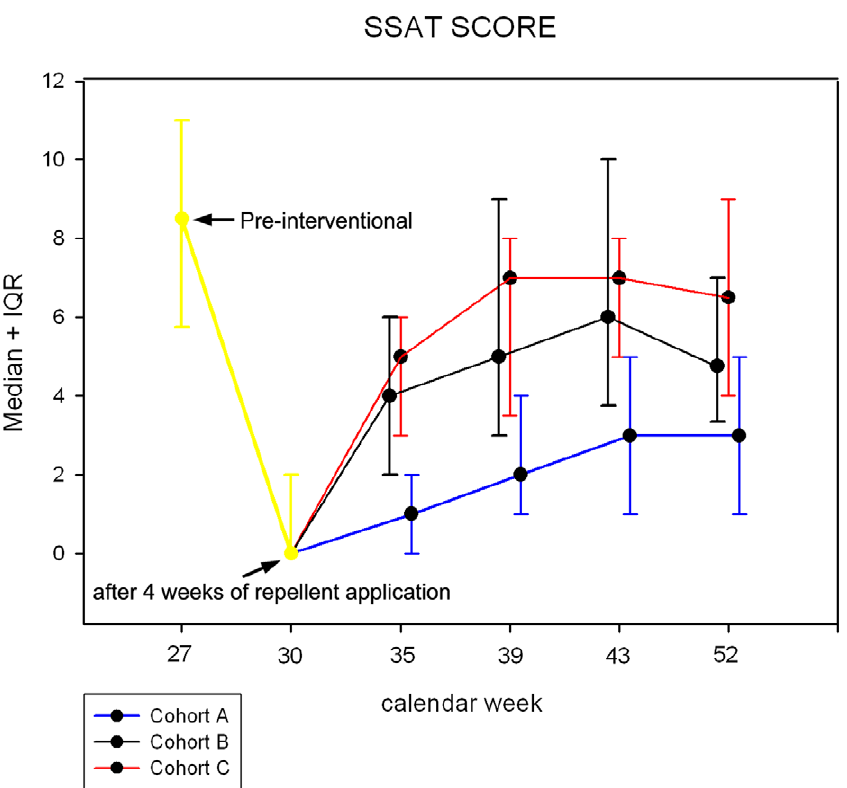
Figure 5. SSAT-scores (median and interquartile range) during the study period. During the first round of application of Zanzarin (twice daily for 4 weeks) the SSAT decreased in an identical manner in the three cohorts. For sake of clarity the data points of cohort B and C were shifted + / 2 0.1 calendar weeks on the x-axis, although the assessment of the SSAT was done simultaneously in the three cohorts.